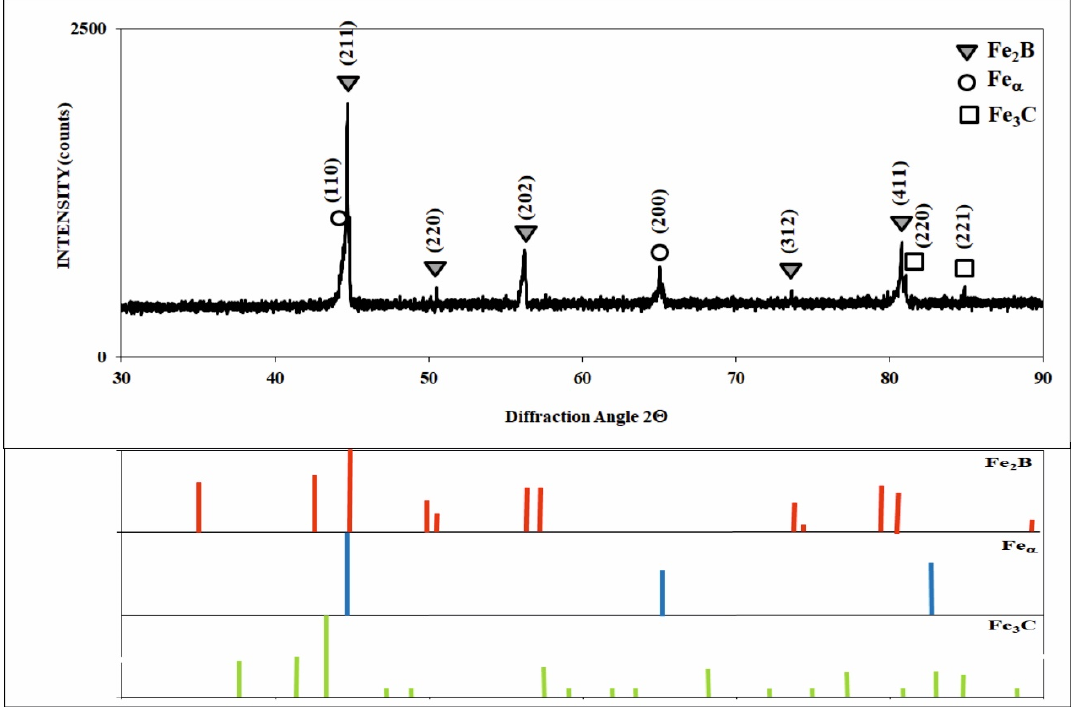
Figure 3 . Results of XRD analysis of gas borocarburized Armco iron and standard patterns for Fe 2 B, Fe α and Fe 3 C.